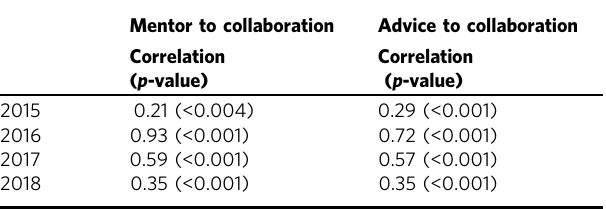
Fig. 7 Advice network is integral to building expertise. This diagram was created by using participant answers to the social network question, “ who do you go to for advice? ” Each circle or node represents a person on the team. The nodes are sized by outdegree to show who reported receiving mentorship. Node size indicates how many mentors an individual reported, and arrows indicate nodes that served as mentors. Colours denote different roles on the team. Table 2 Interpersonal relationships drive scienti fi c